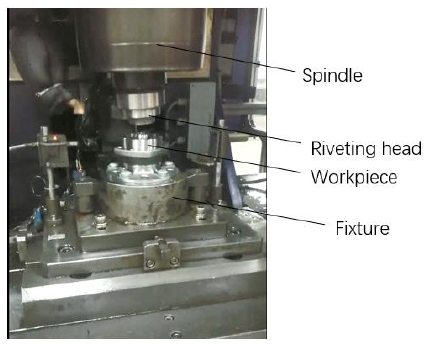
Figure 2. Riveting machine.